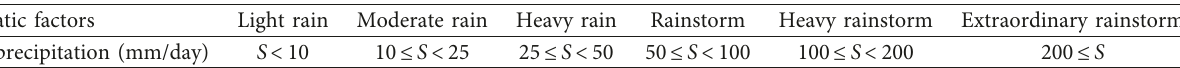
Table 5: Precipitation grade